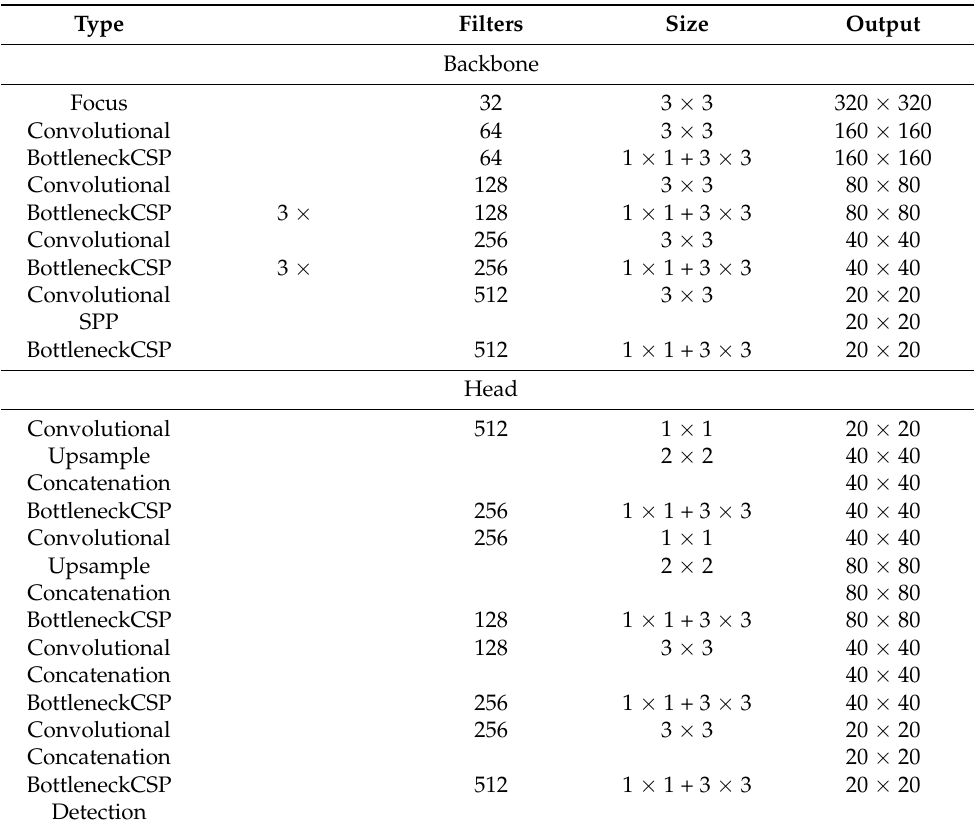
Table 1. Architecture of the YOLOv5s model